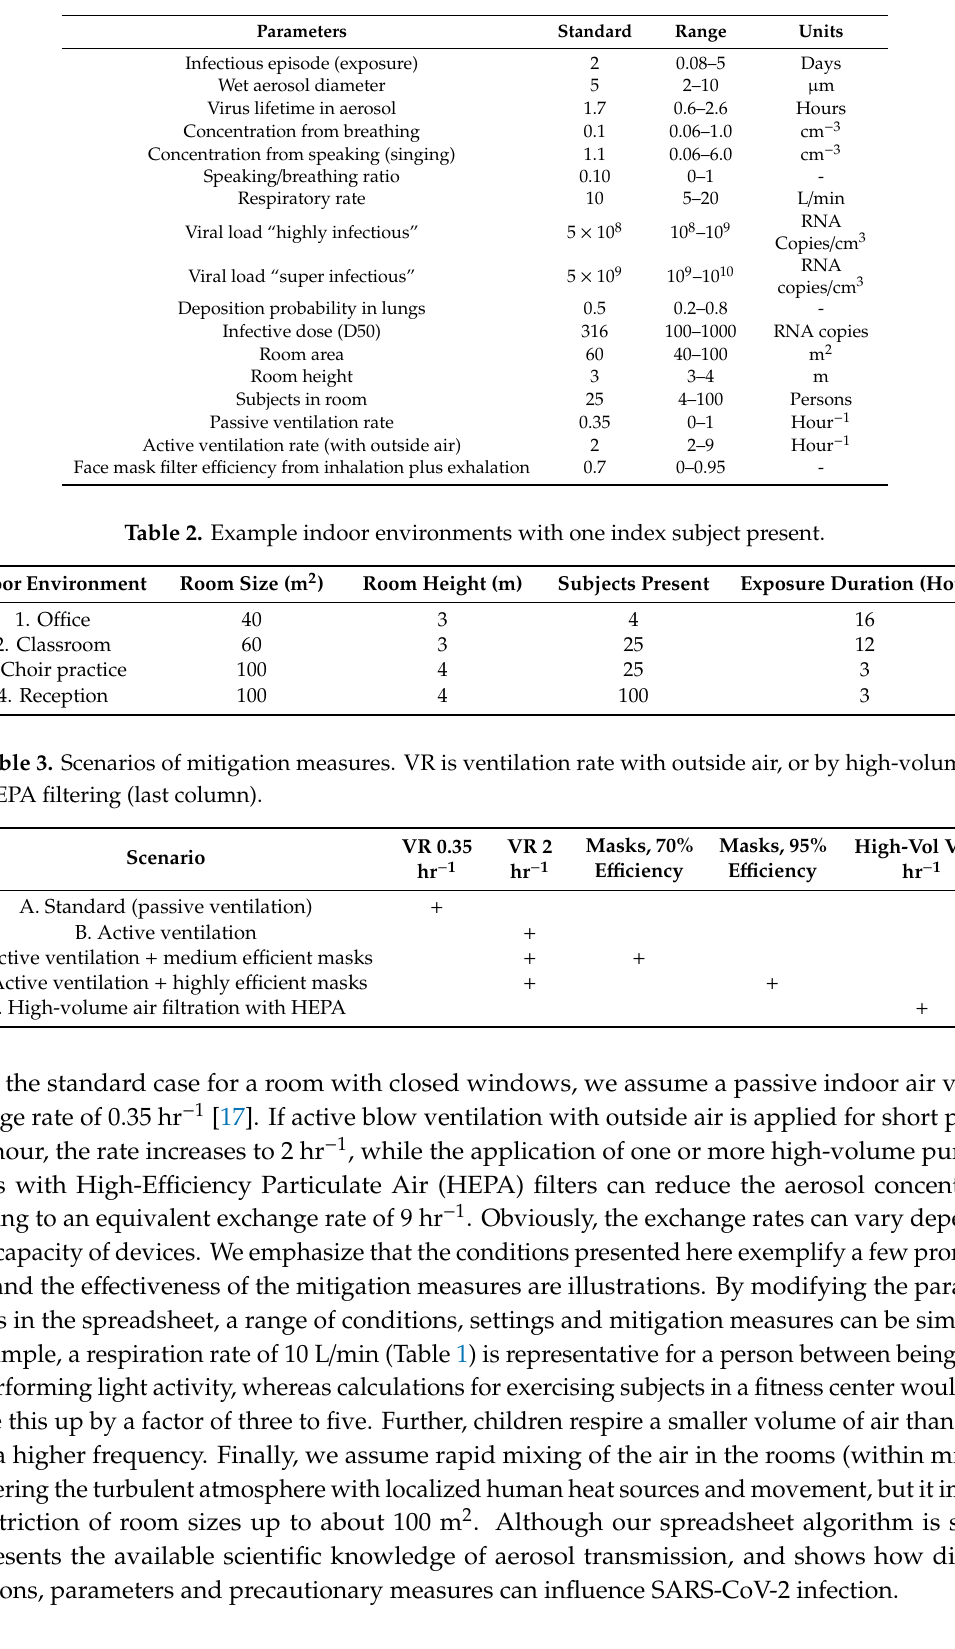
Table 1. Model parameters and ranges applied to compute infection risk. Standard setting refers to a classroom (indoor environment nr. 2 in Table 2). The spreadsheet is available in the Supplementary Material and additionally online: https: // www.mpic.de / 4747065 / risk-calculation.